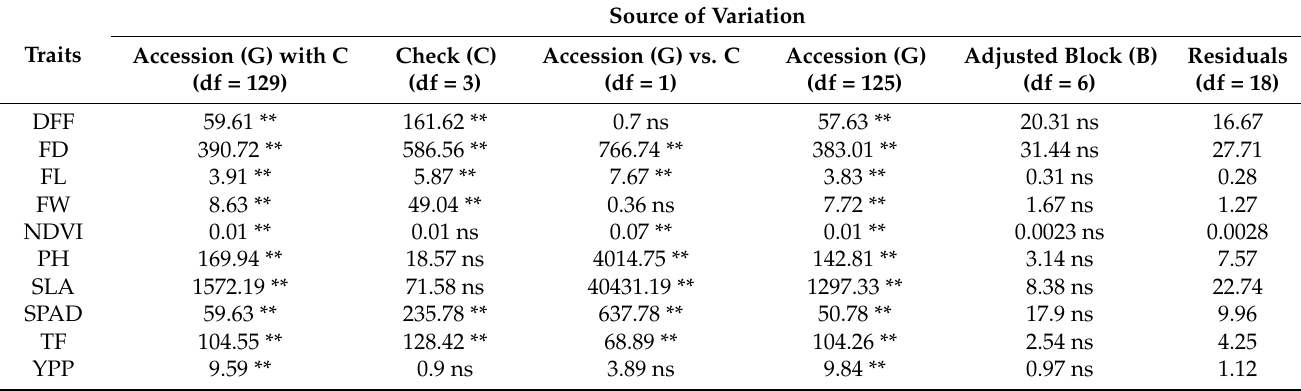
Table 4. Analysis of variance of the tested quantitative traits. Source of